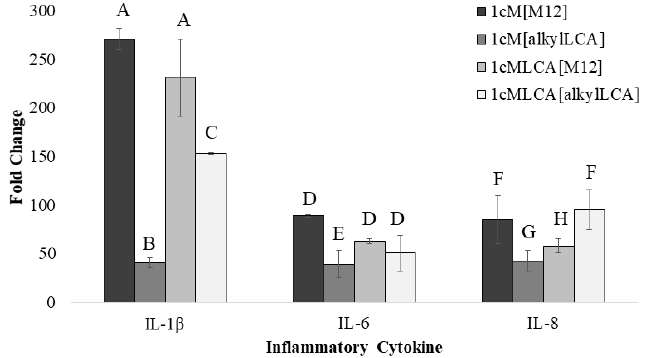
Figure 5. Fold change in mRNA levels of inflammatory cytokines and scavenger receptors (SRs) in hMDMs as determined by rt-PCR 24 h after treatment with AScM NPs and oxLDL as compared to untreated (basal) controls. Transcription levels of three cytokines significantly affected by NP treatment. Different letters indicate statistical significance, whereas identical letters indicate no statistical difference.